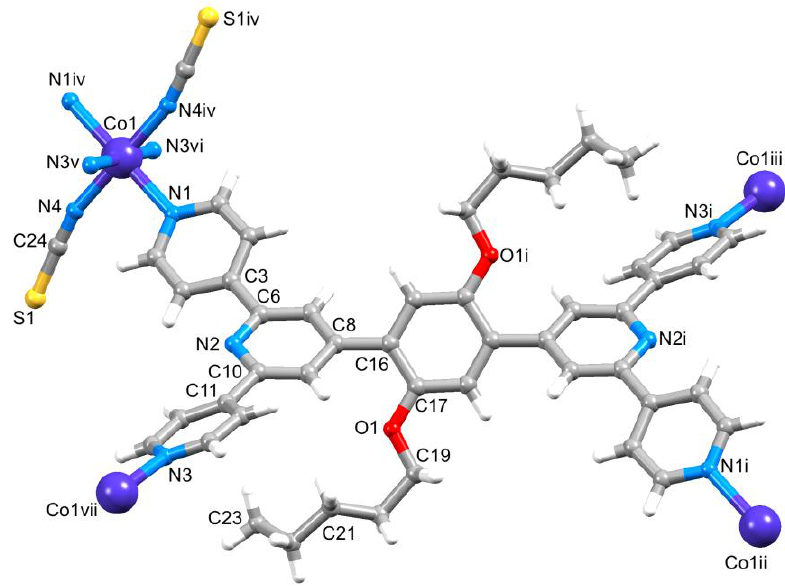
Figure 2. The asymmetric unit in {[Co(NCS) 2 ( 3 )] · 0.8C 6 H 4 Cl 2 } n and symmetry-generated atoms to show ligand 3 as a 4-connecting node. Symmetry codes: i = − 1 − x , 1 – y , 1 − z ; ii = − 1 + x , y , 1 + z ; iii = − 1 + x , 3 / 2 − y , 1 / 2 + z ; iv = − x , 1 − y , − z ; v = x , 1 / 2 − y , − 1 / 2 + z ; vi = − x , 1 / 2 + y , 1 / 2 – z ; vii = x , 1 / 2 − y , 1 / 2 + z